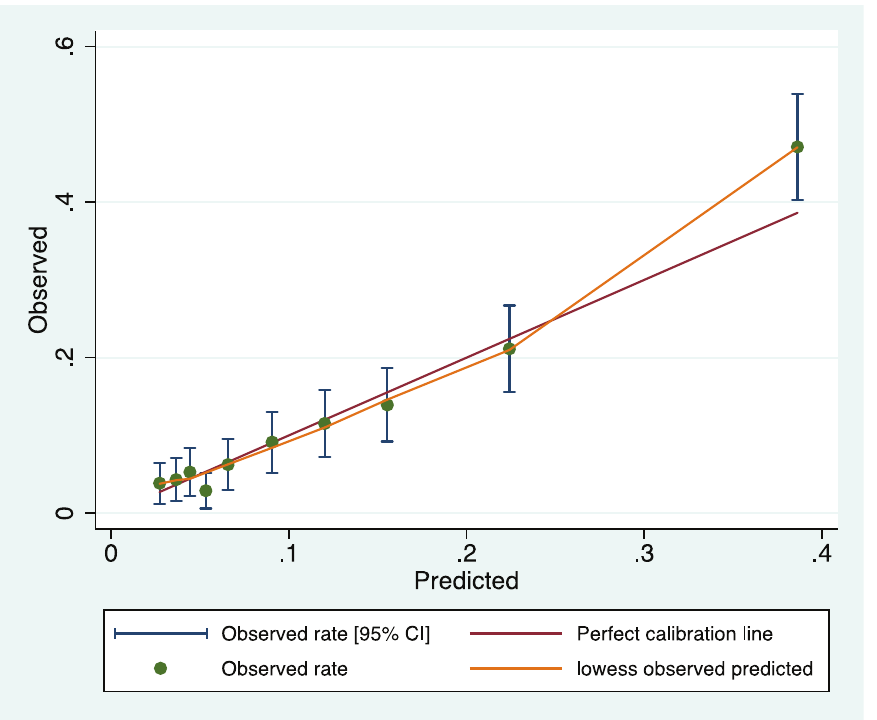
Figure 1. Calibration plot of the miniPIERS model applied 2,081 women in the cohort (H–L goodness of fit p =0.1616). Green line represents line of perfect fit between observed and predicted outcomes and orange line is a smoothed fit line between predicted probability and mean observed probability in each range.